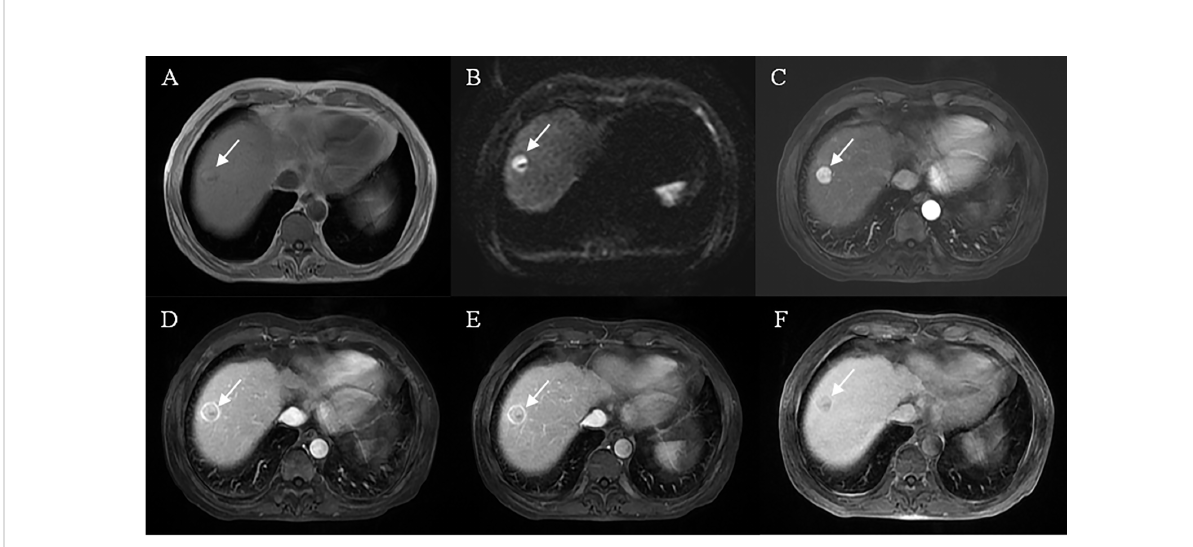
FIGURE 4 Representative images of MVI negative case: A 61-year-old male, the lesion located at hepatic segment VIII (A) , restricted diffusion (B) , but showed a well-circumscribed smooth tumor edge and complete capsule enhancement (D, E) , typical enhancement pattern with “ wash-in ” and “ wash-out ” (C – E) , without peritumoral enhancement on arterial phase images (C) and mild HBP hypointensity (F)